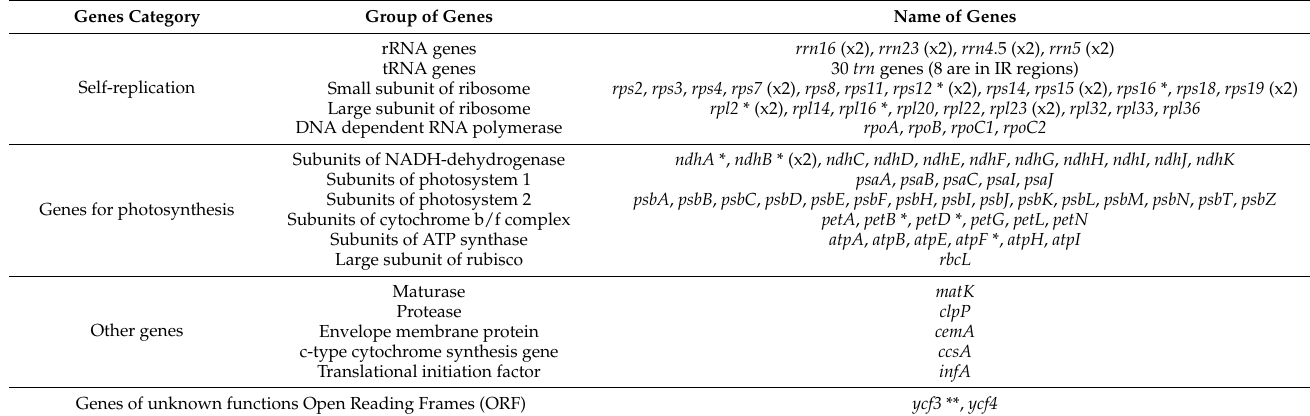
Figure 1. Genome map of the complete chloroplast sequences of Zoysia japonica and three other Zoysia species sequenced in this study. The gene order and structure among Zoysia species are the same. The gray region within the inner circle shows the GC content ratio. Table 2. Genes in the Zoysia plastomes. Each species has 110 unique